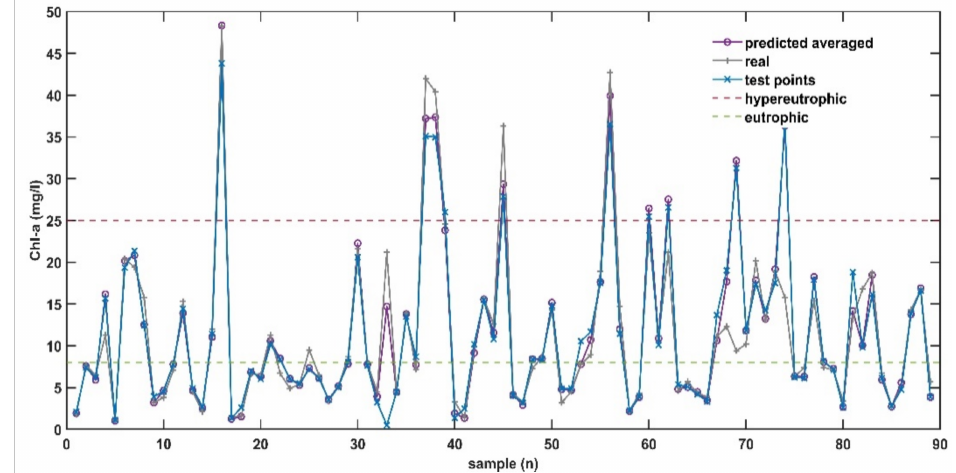
Figure 6. Graphical representation of the monitored (real) chlorophyll- a (Chl- a ) values against the averaged predicted values and the test data. The green and red dotted horizontal lines show the Chl- a limits for when a lake becomes eutrophic and hypereutrophic [44],